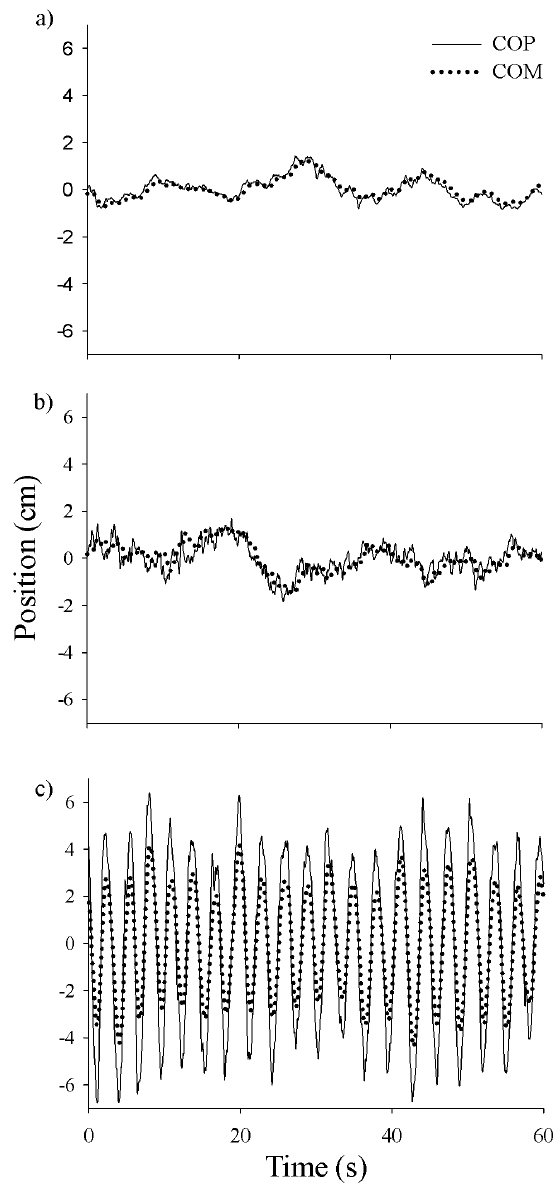
Figure 1. A representative participant’s COP and COM motion at different standing conditions: a) Side-by-side; b) single left- foot standing; c) single left-foot standing with body rocking at the ankle